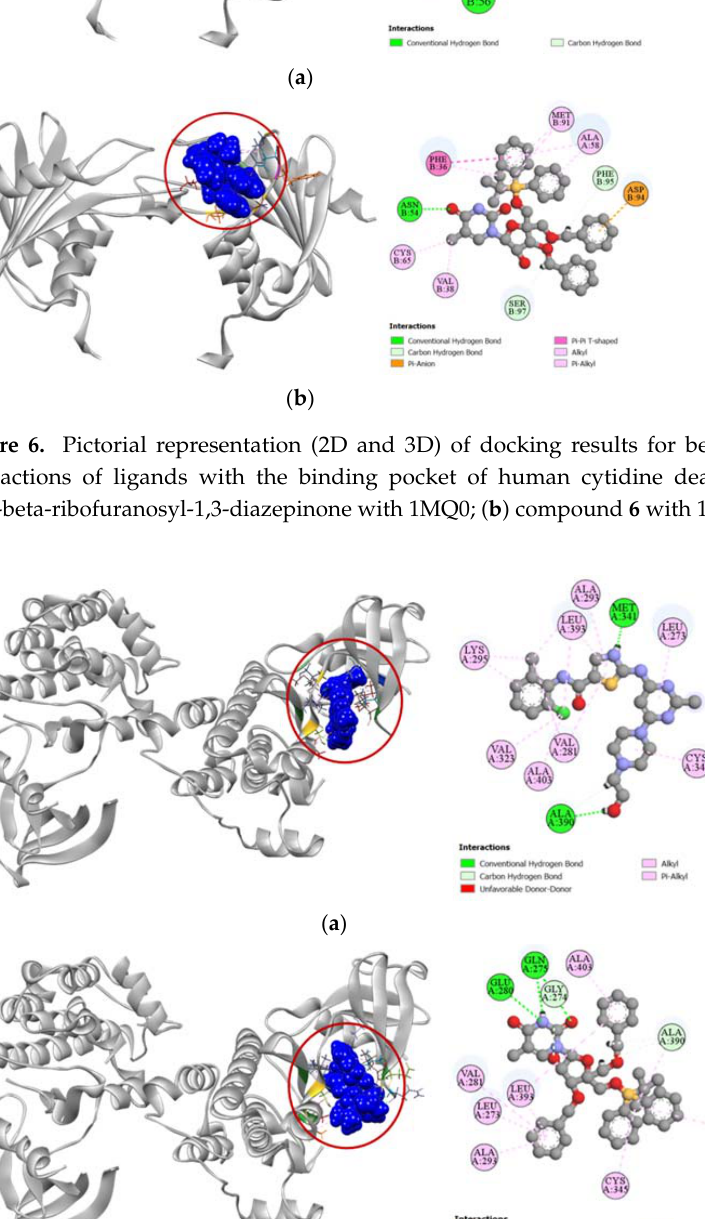
Figure 7. Pictorial representation (2D and 3D) of docking results for best-ranked pose of key interactions of ligands with the binding pocket of proto-oncogene tyrosine-protein kinase Src (PDB: 3G5D). ( a ) dasatinib with 3G5D; ( b ) compound 6 with 3G5D.